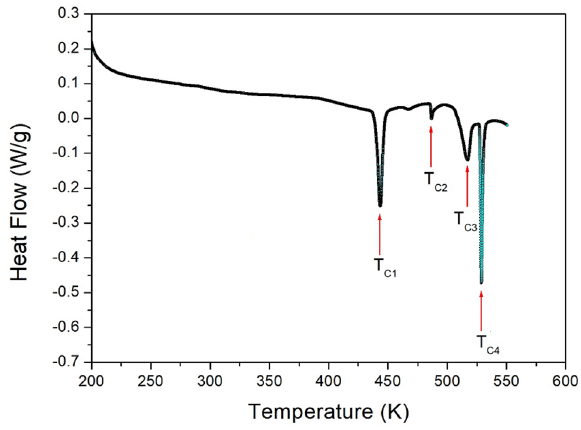
Figure 2. Differential scanning calorimetry curve of [NH 3 (CH 2 ) 2 NH 3 ] 2 CdBr 4 ·2Br.